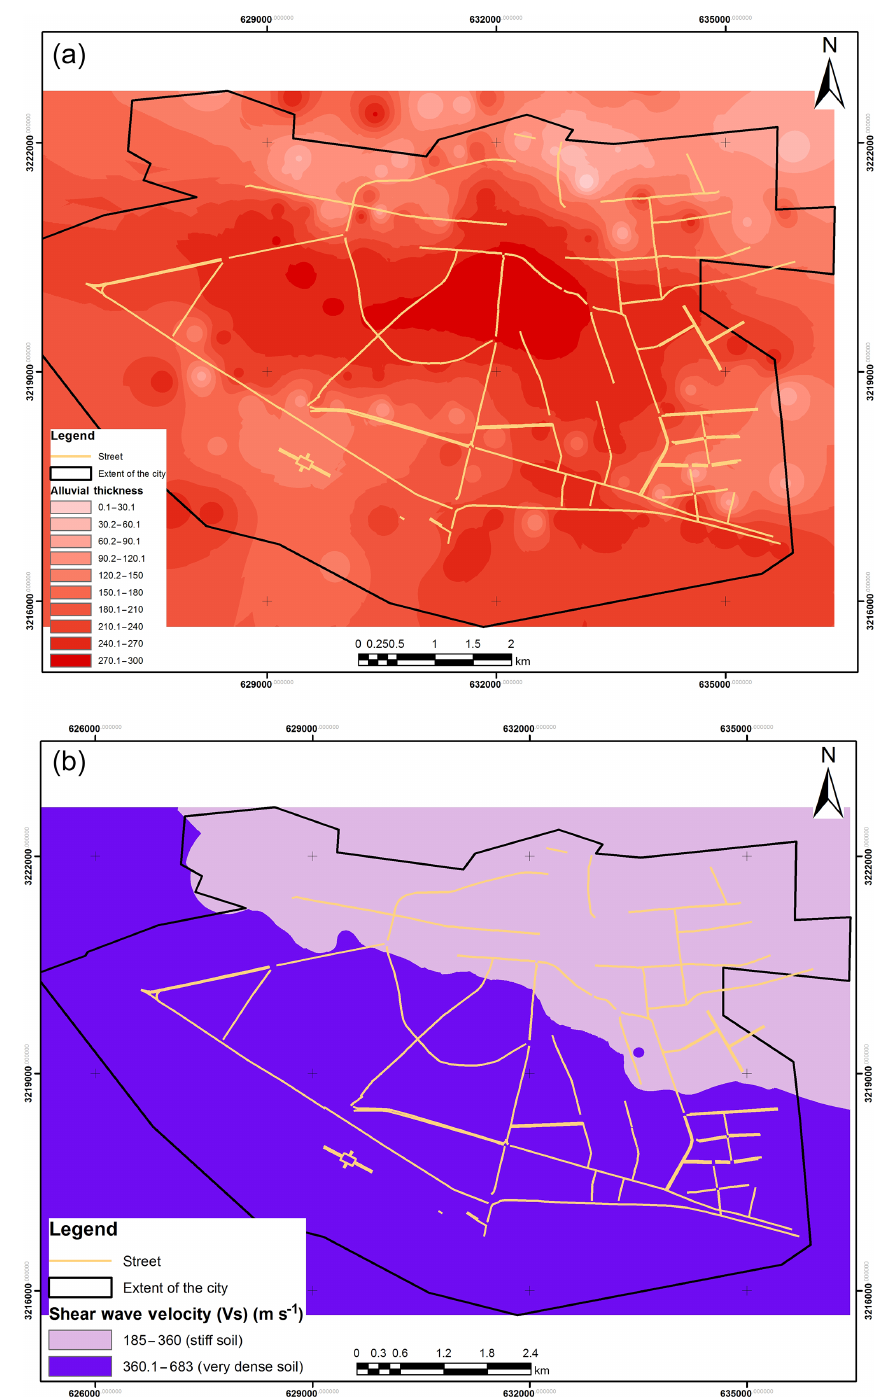
Figure 6. Thematic layers of Bam City: alluvial thickness (m) (a) and stiffness and strength of soil and sediments (b)